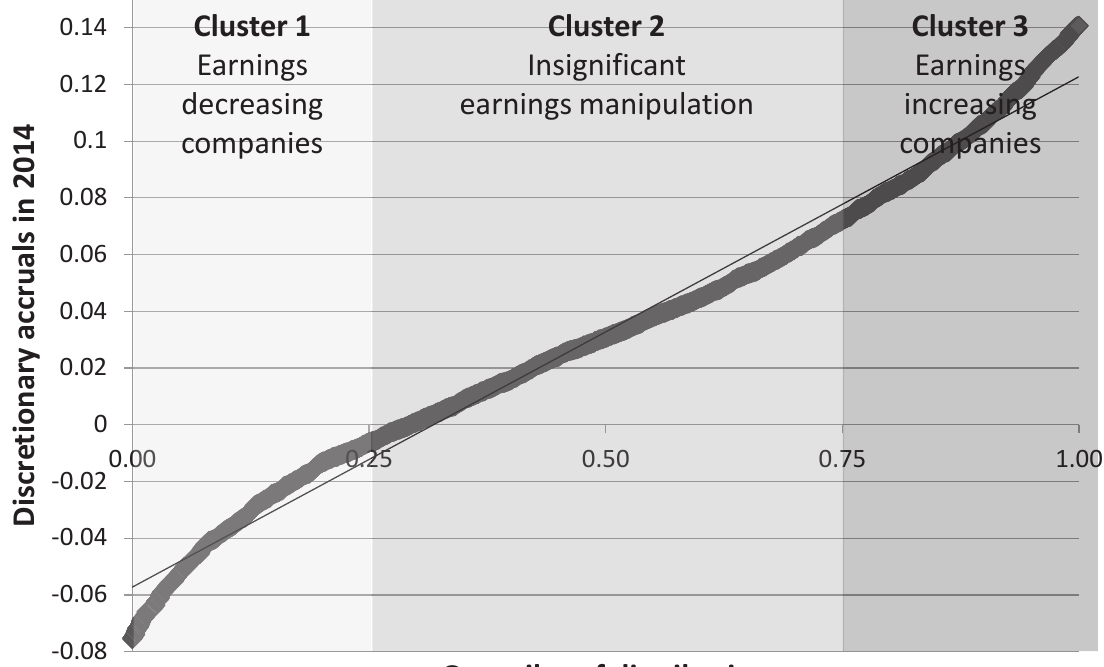
Figure 2a. Quantiles of distribution of discretionary accruals of the companies of the sample based on actual data for 2014 (Russia)